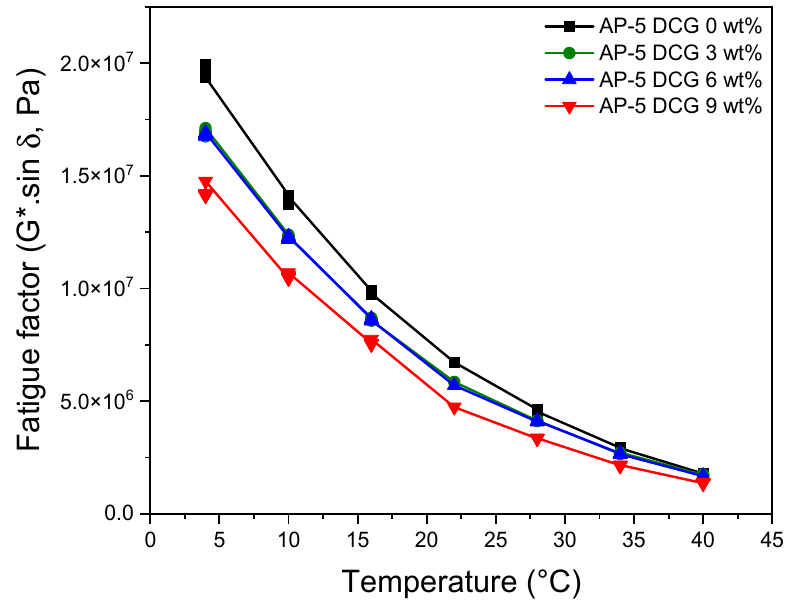
Figure 14. Variation of fatigue factor (G*.sin δ ) as function of temperature for PAV-aged base AP-5 asphalt and its modified specimens comprising various doses of DCG (e.g., 3, 6, 9 wt%).